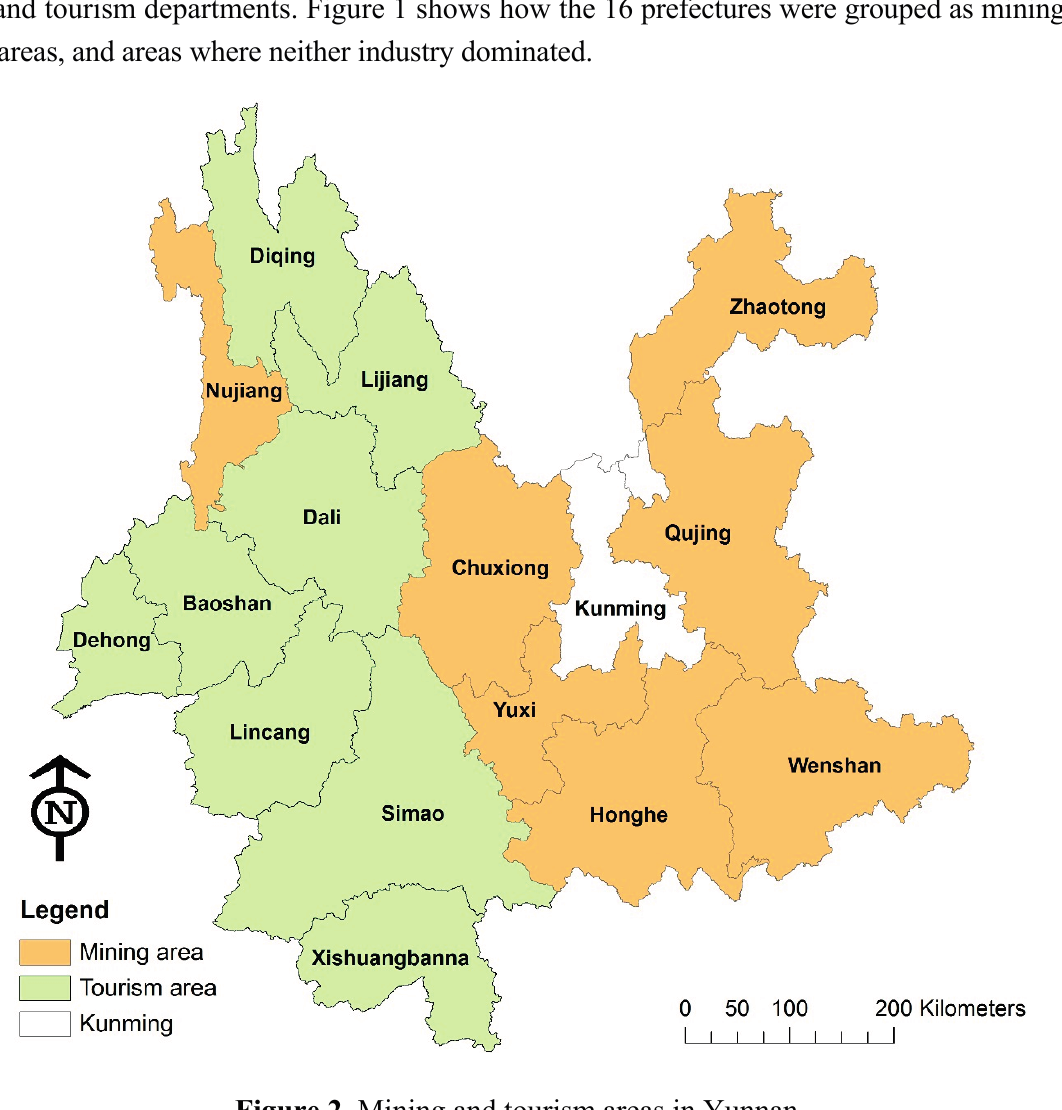
Figure 2. Mining and tourism areas in